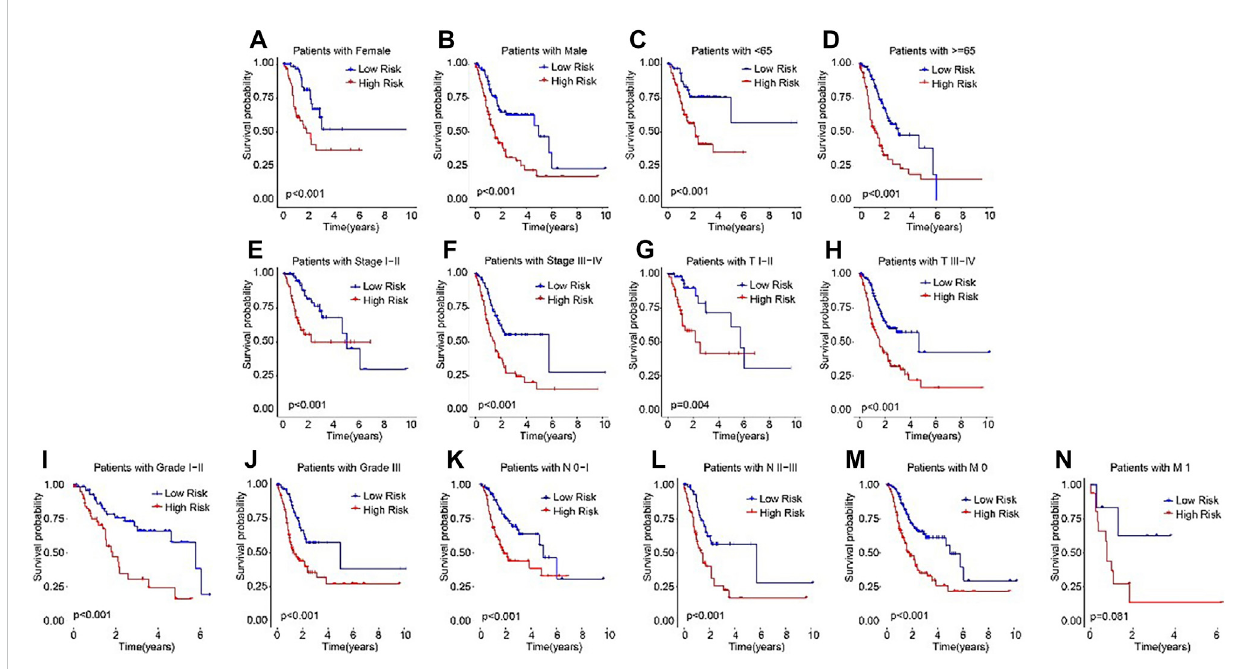
FIGURE 4 The Kaplan-Meier survival analysis of STAD patients in the different clinicopathological characteristics subgroups. The Kaplan-Meier survival curve analysis shows the OS rate of patients in the low- and high-risk groups among the (A, B) Gender (female vs. male); (C, D) Age (age > 65 vs. age ≤ 65); (E, F) Stage (stage0 – 1 vs.stage2 – 4); (Giletal.,2104); (G,H) T(T0 – 1vs.T2 – 4); (I,J) Grade(G1 – 2vs.G3); (K, L) N(N0 – 1vs. N2 – 3);and (M,N)